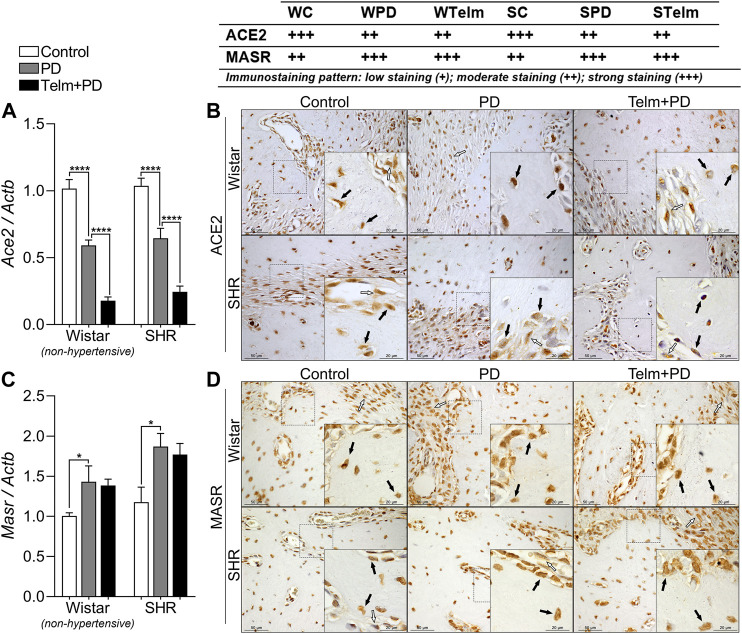
RAS components expression in mandibles of Wistar (non-hypertensive) and SHR with PD 15 days, treated with telmisartan. Respectively qRT-PCR and IHC for Ace2 (A,B), and Masr (C,D). Graphs show mean ± SEM (n = 6). Statistical difference are represented by brackets labeled by *p < 0.05, **p < 0.01, ***p < 0.001, and ****p < 0.0001, comparing Control vs. PD, PD vs. Telm + PD, and Wistar vs. SHR in the same experimental condition. Board shows representative images, and upper table presents the average immunostaining patter from each experimental group (n = 5). Black arrows point bone forming cells positive stained (osteoblasts and osteocytes), and white arrows indicate positive stained alveolar bone adjacent connective tissue.